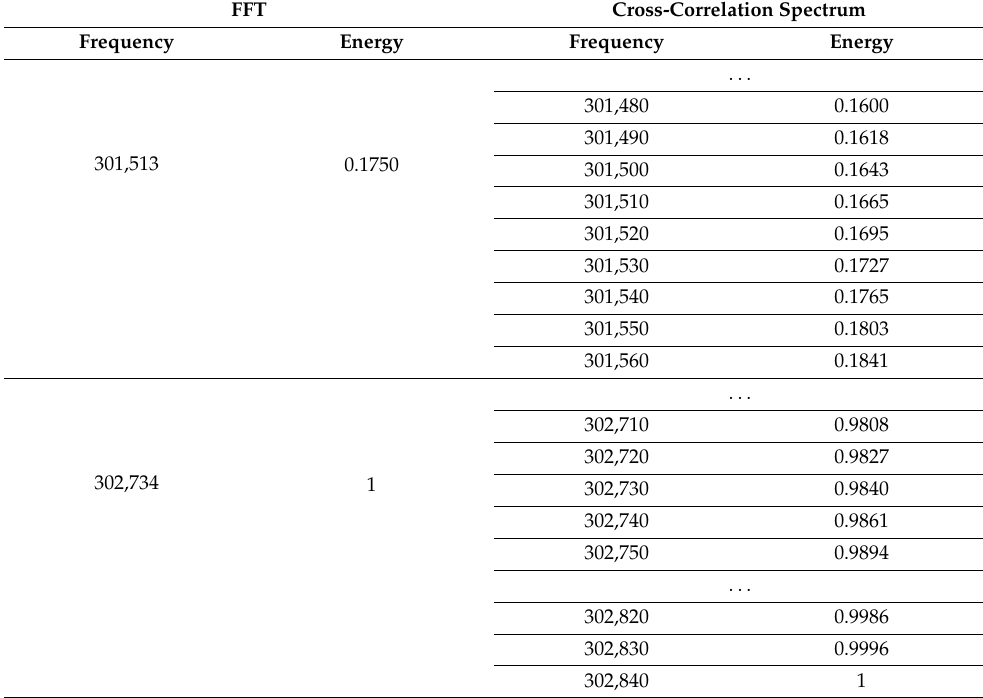
Table 2. Energy of the FFT and the cross-correlation